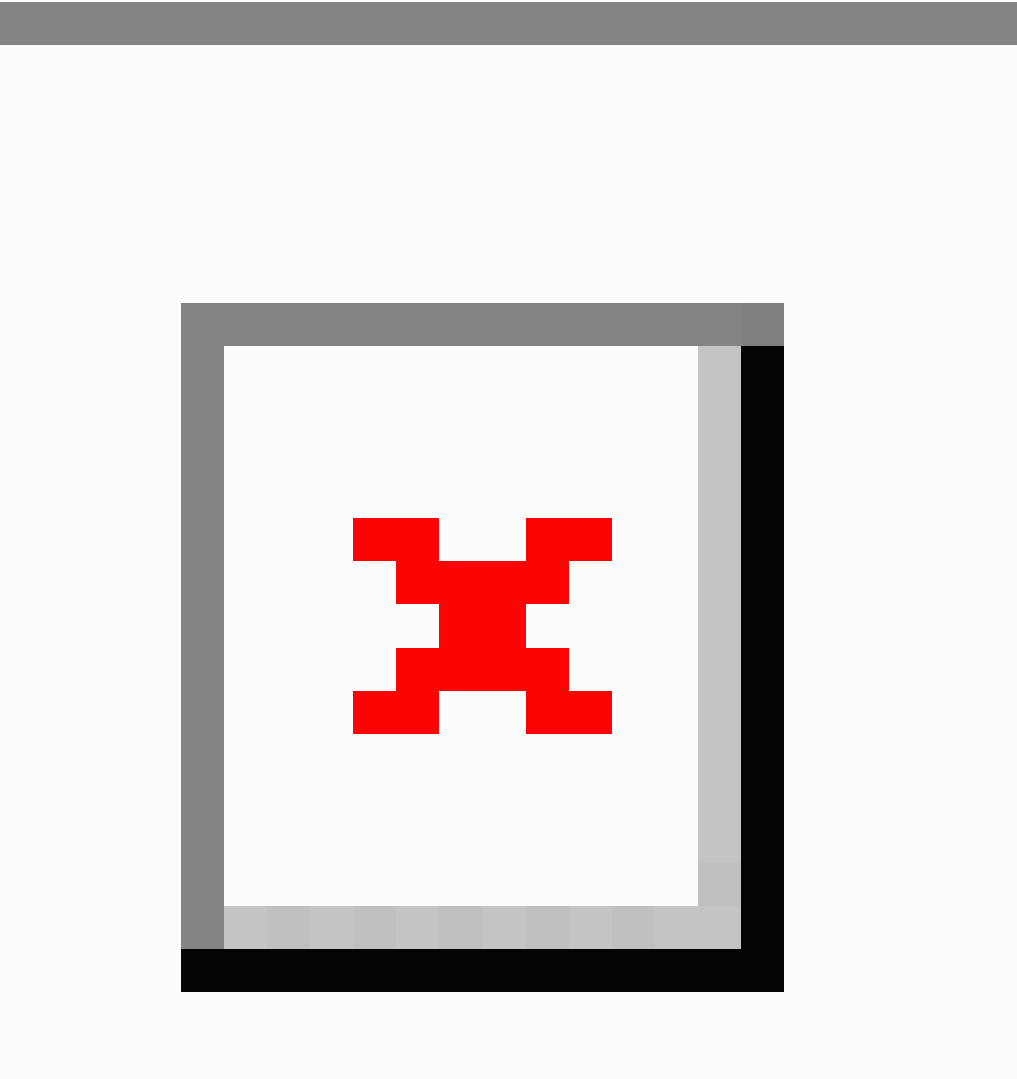
Figure 8. Bland-Altman plot of the difference between the estimated distance walked and the ground truth. The Shapiro-Wilk test confirms the normality of the data